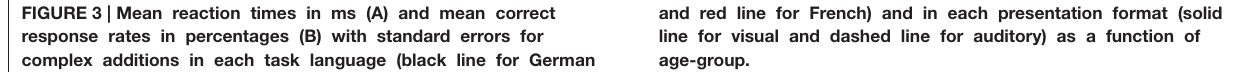
FIGURE 3 | Mean reaction times in ms (A) and mean correct response rates in percentages (B) with standard errors for complex additions in each task language (black line for German